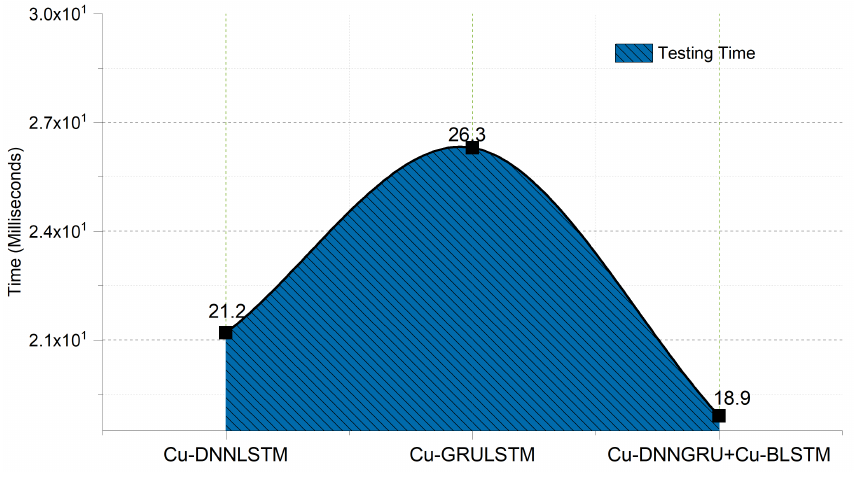
Figure 8. Testing time of CU-DNNGRU + Cu-BLSTM, Cu–DNNGRU, and